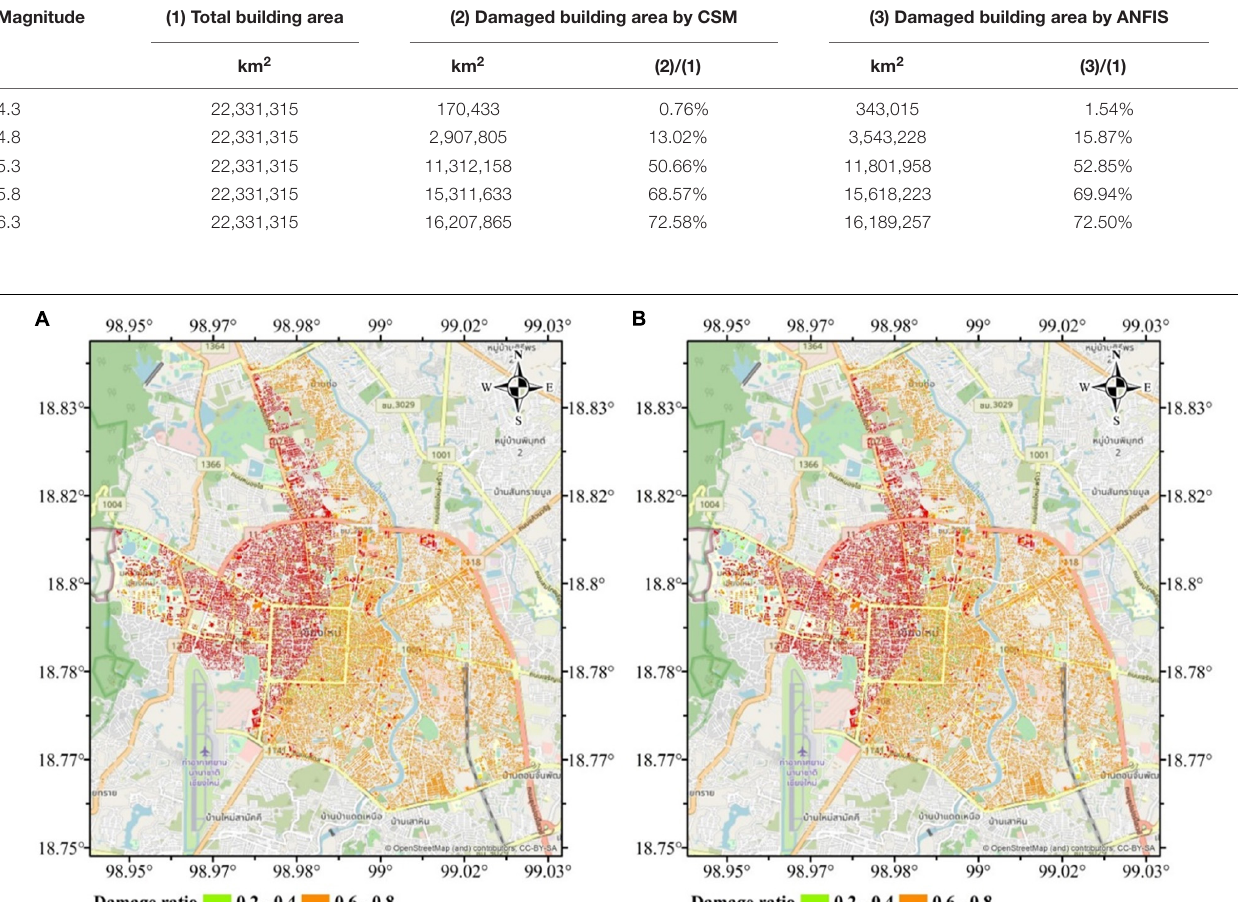
Frontiers in Built Environment |